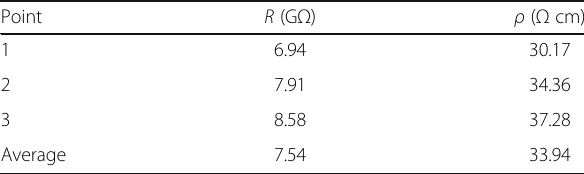
Table 2 The resistance and resistivity of a single wire measured by AFM at different